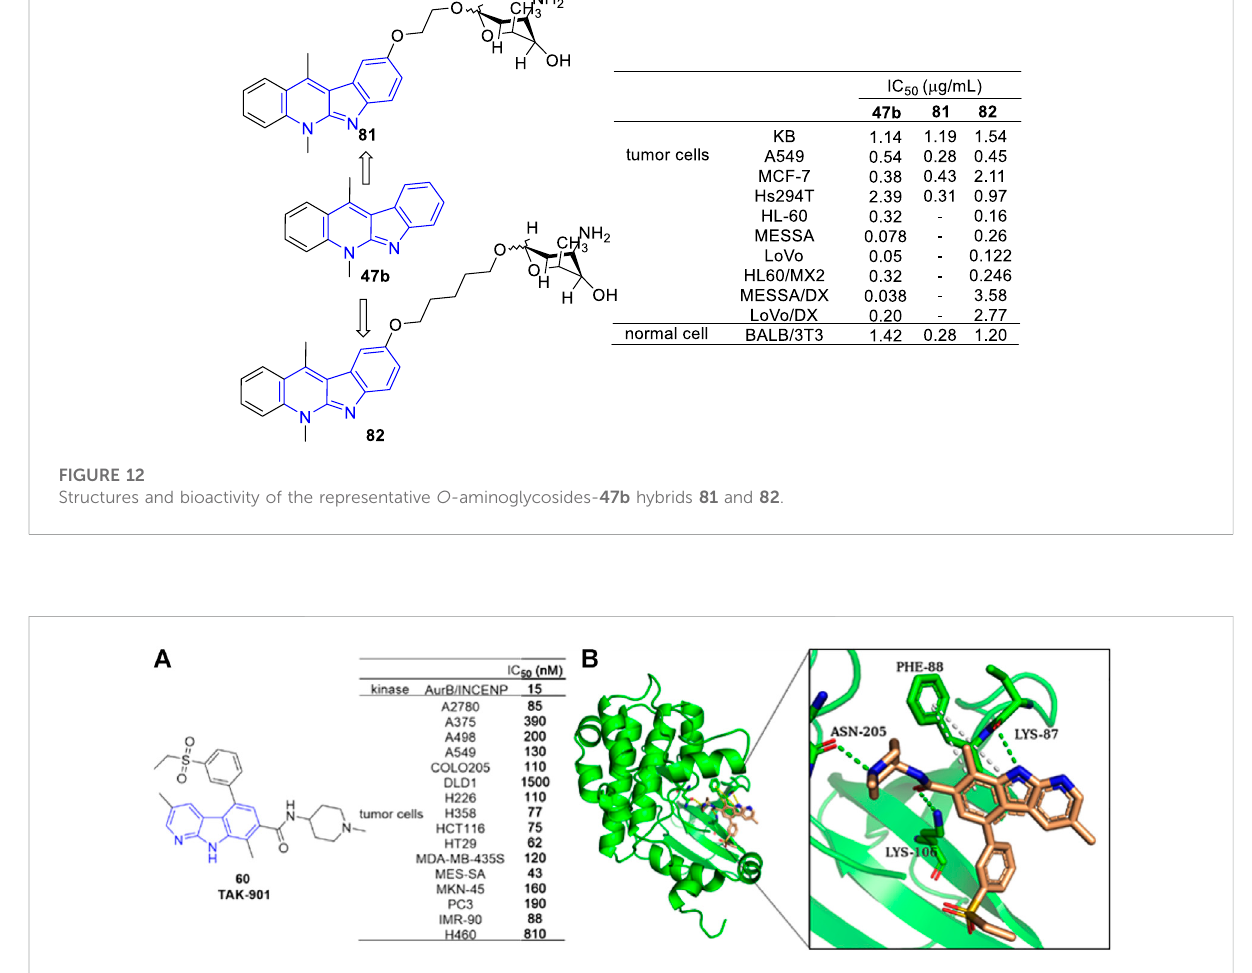
FIGURE 13 (A) Structure and bioactivity of 88 as an Aurora B inhibitor; (B) Binding mode of 88 docked into Aurora B kinase (green ribbon representation, PDB code: 4AF3). 88 is represented in stick model, carbons in ligand are colored wheat. Hydrogen bond is presented as green dash lines. π - π interactions are presented as white dash